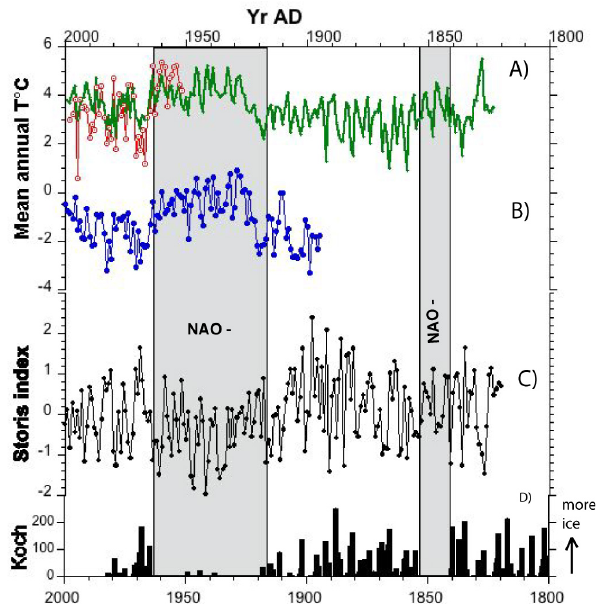
Fig. 3. Historical data from the area of Denmark Strait: (A) mean annual temperature data from W Iceland (green), and the Siglunes (red) marine record (Fig. 1); (B) MAT (blue) from SE Greenland; (C) index of storis (Schmith and Hanssen, 2003); (D) revised Koch sea-ice index. Grey shaded areas represent intervals of reduced drift ice during inferred NAO negative circulation (Fig. 2).